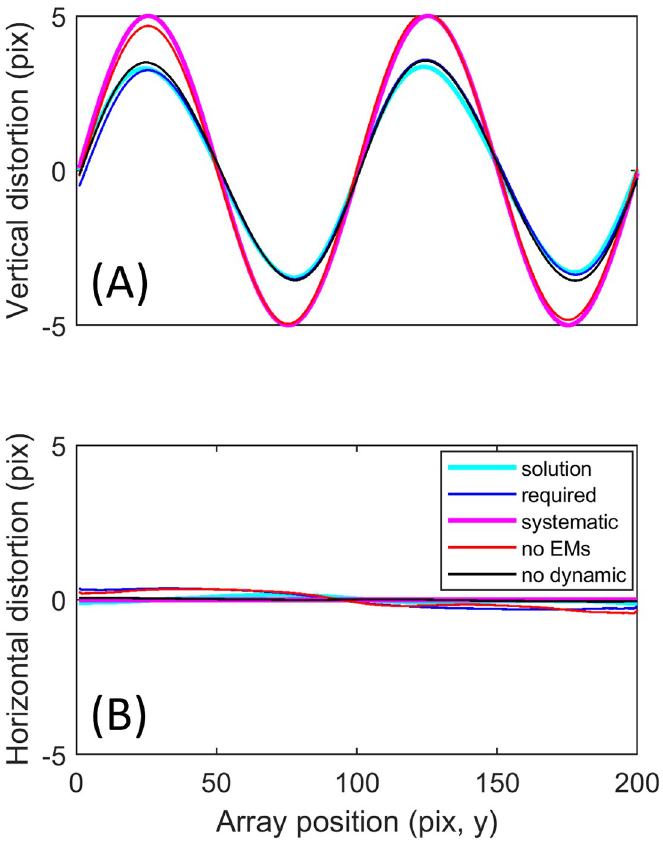
Fig 7. Static distortion profiles applied and recovered in the presence of dynamic distortion. Six clusters of 1000 frames were generated (see text and Fig 8). Average distortion along the y array direction is plotted for vertical distortions (A) and horizontal distortions (B). The recovered solution is shown in cyan, matching the required solution in blue. The true underlying static distortion is shown in magenta, but this is only the correct solution when the eye did not move vertically (red). Black shows the solution when there were only eye movements (no sinusoidal warp applied).